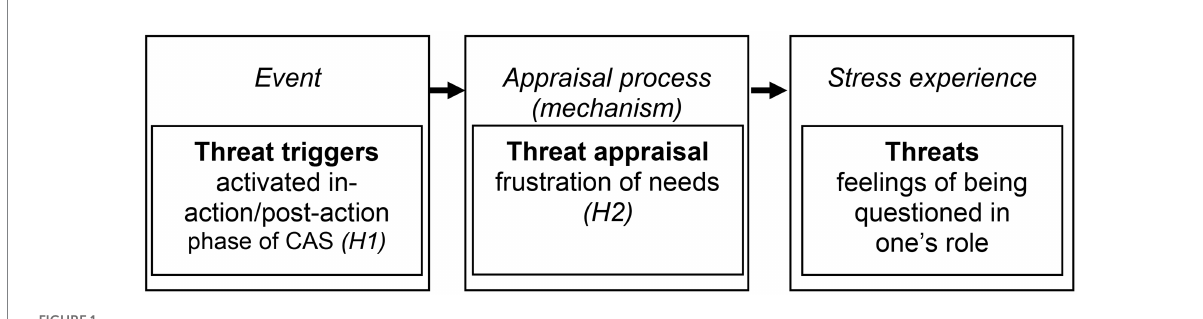
FIGURE 1 Overview of determinants in the threat